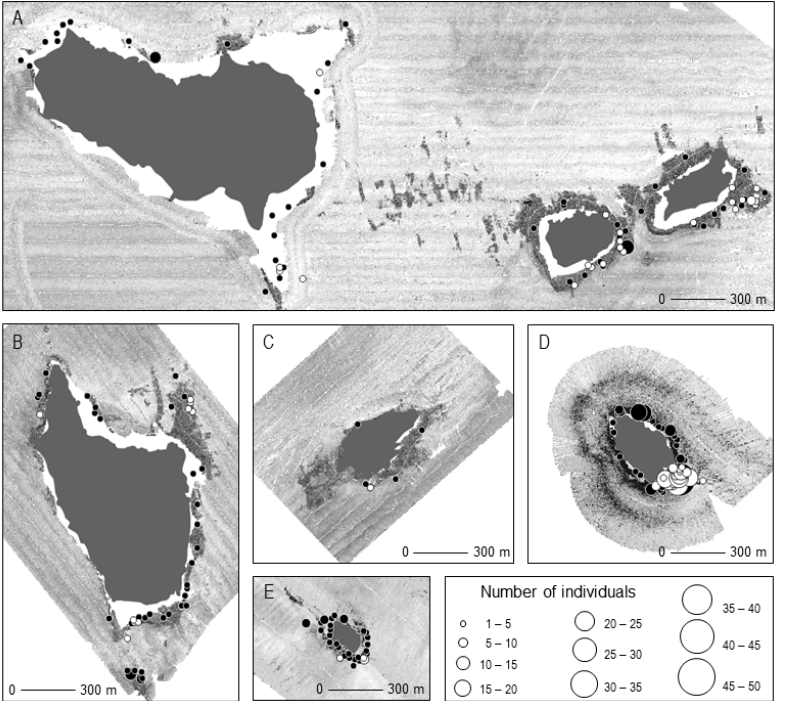
Figure 6. Spatial distribution of goliath groupers ( Epinephelus itajara ) around Rémire islands ( A ) La Mère and Mamelles, ( B ) Le Père, ( C ) Malingre) and in the Grand Connétable Island Marine Protected Area (( D ): Grand Connétable, ( E ): Petit Connétable). Gray shaded: bottom substrate type (light gray for mud and sand; dark gray for rock, obtained from side-scan sonar mapping). White points: fishing observations, black points: acoustic camera observations.